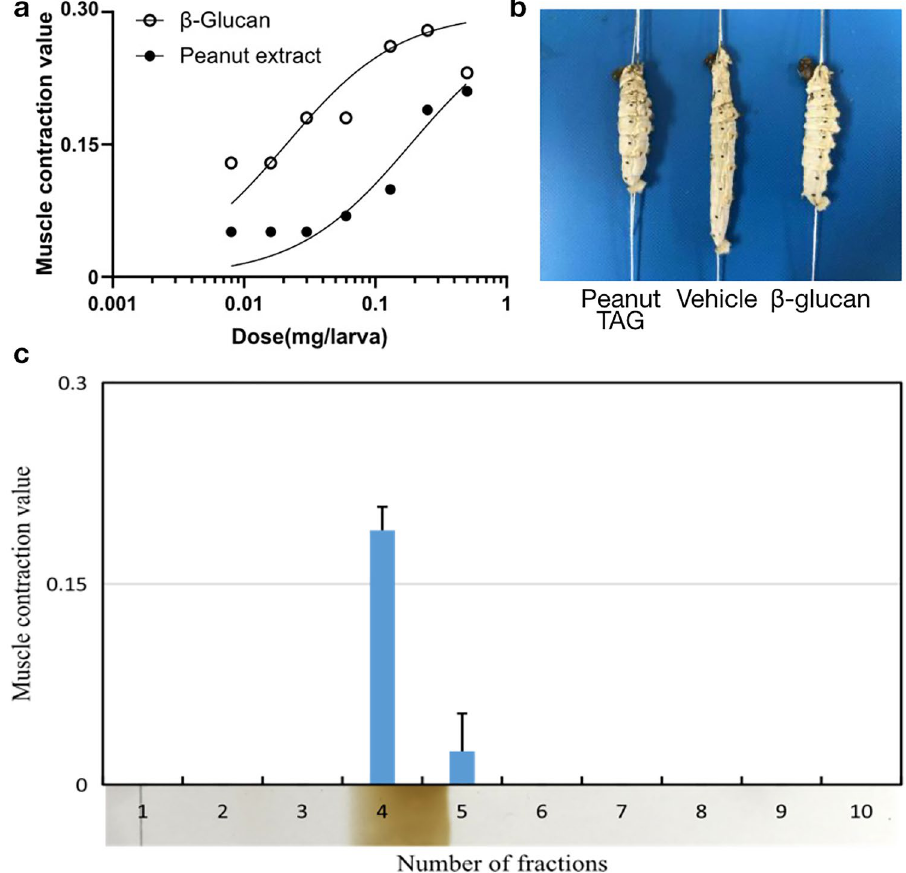
Figure 3. Muscle contraction of the silkworm induced by peanut TAGs. ( a ) The (purified) peanut TAGs dose-dependently showed a muscle contraction effect on the silkworm. The y-axis represents the contraction (C-) value, and the x-axis represents the dosage (mg/larva). Each plot represents a result from one silkworm specimen. Calculation procedure of C-values is described in “Materials and Methods”. ( b ) A representative photo from the muscle contraction assay using the silkworm. Either the peanut TAGs (17 mg), the vehicle (water), or the yeast β-glucan (4.0 mg) was injected to the silkworm specimen. As shown in the figure, the peanut TAG and the yeast β-glucan induced the muscle contraction, while the vehicle did not. ( c ) The muscle contraction inducing activity co-migrated with the TLC spot. Thirty milligrams of the purified peanut TAG (as shown in Fig. 2a) was separated on the TLC and re-extracted. When re-extracted, the substance in the major spot on the TLC (fraction 4 as shown in the bottom panel) induced the muscle contraction. The y-axis of the top panel represents the C-value in the muscle contraction assay. The mean value and the standard deviation obtained from duplicate measurements are shown in the